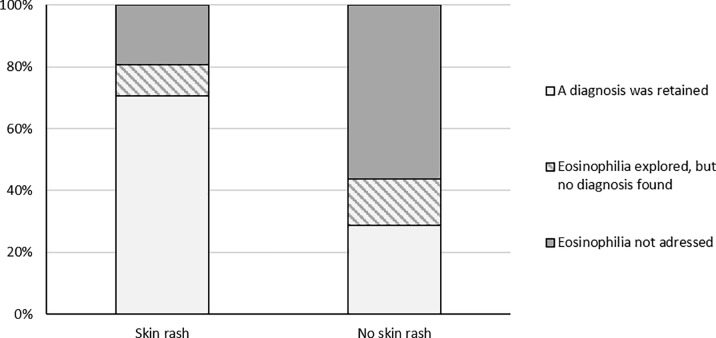
Influence of the presence of a skin rash on the diagnostic process (patients with a skin rash (N = 78) or without a skin rash (N = 220).